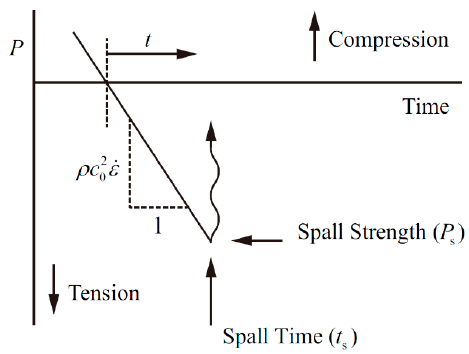
Figure 7. P - t relationship of the Grady spallation model.